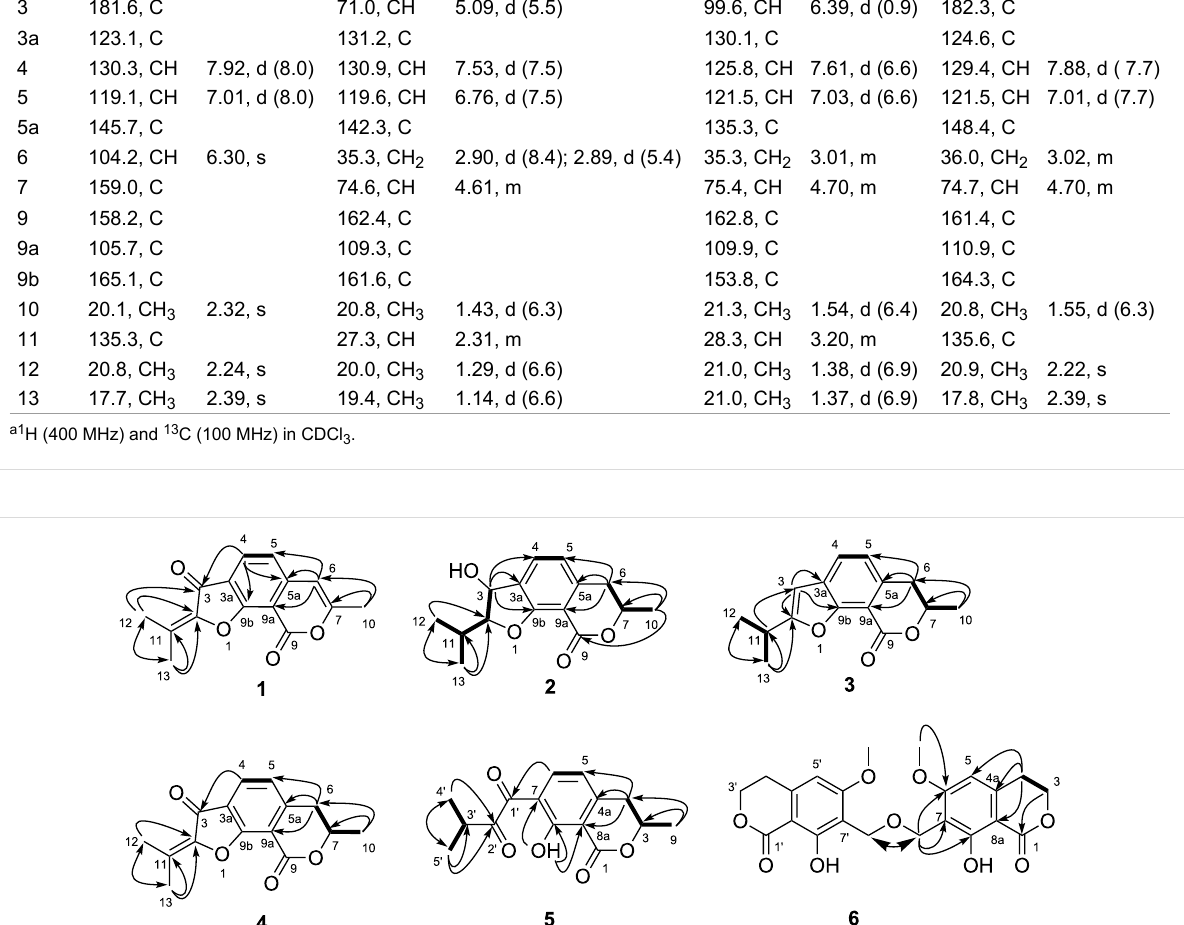
Figure 2: Key HMBC (arrows) and COSY (bold lines) correlations of compounds 1 − 6 .